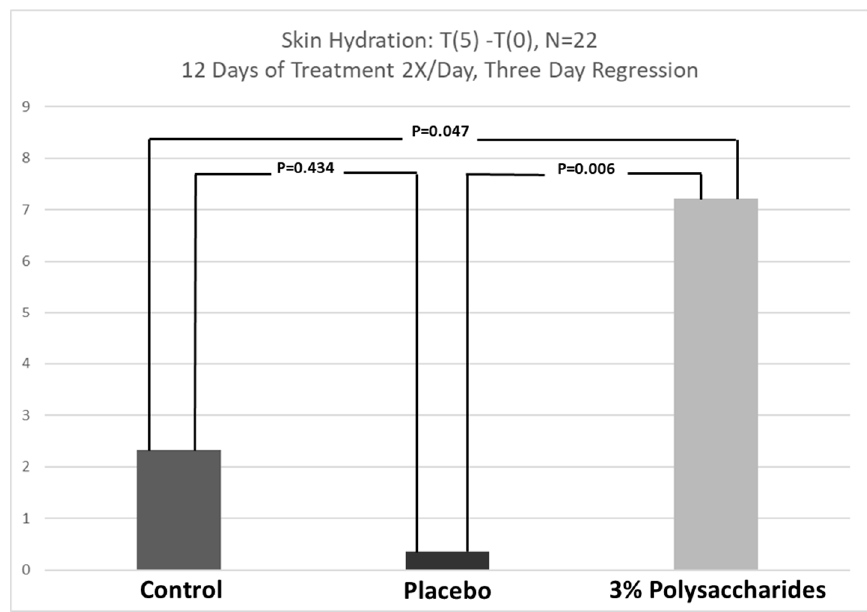
Figure 5. Results of 3-day skin hydration regression study. Dark grey is the untreated control site, black is the retinol placebo-treated site and light grey is the polysaccharide active-treated site. N = 22, p ≤